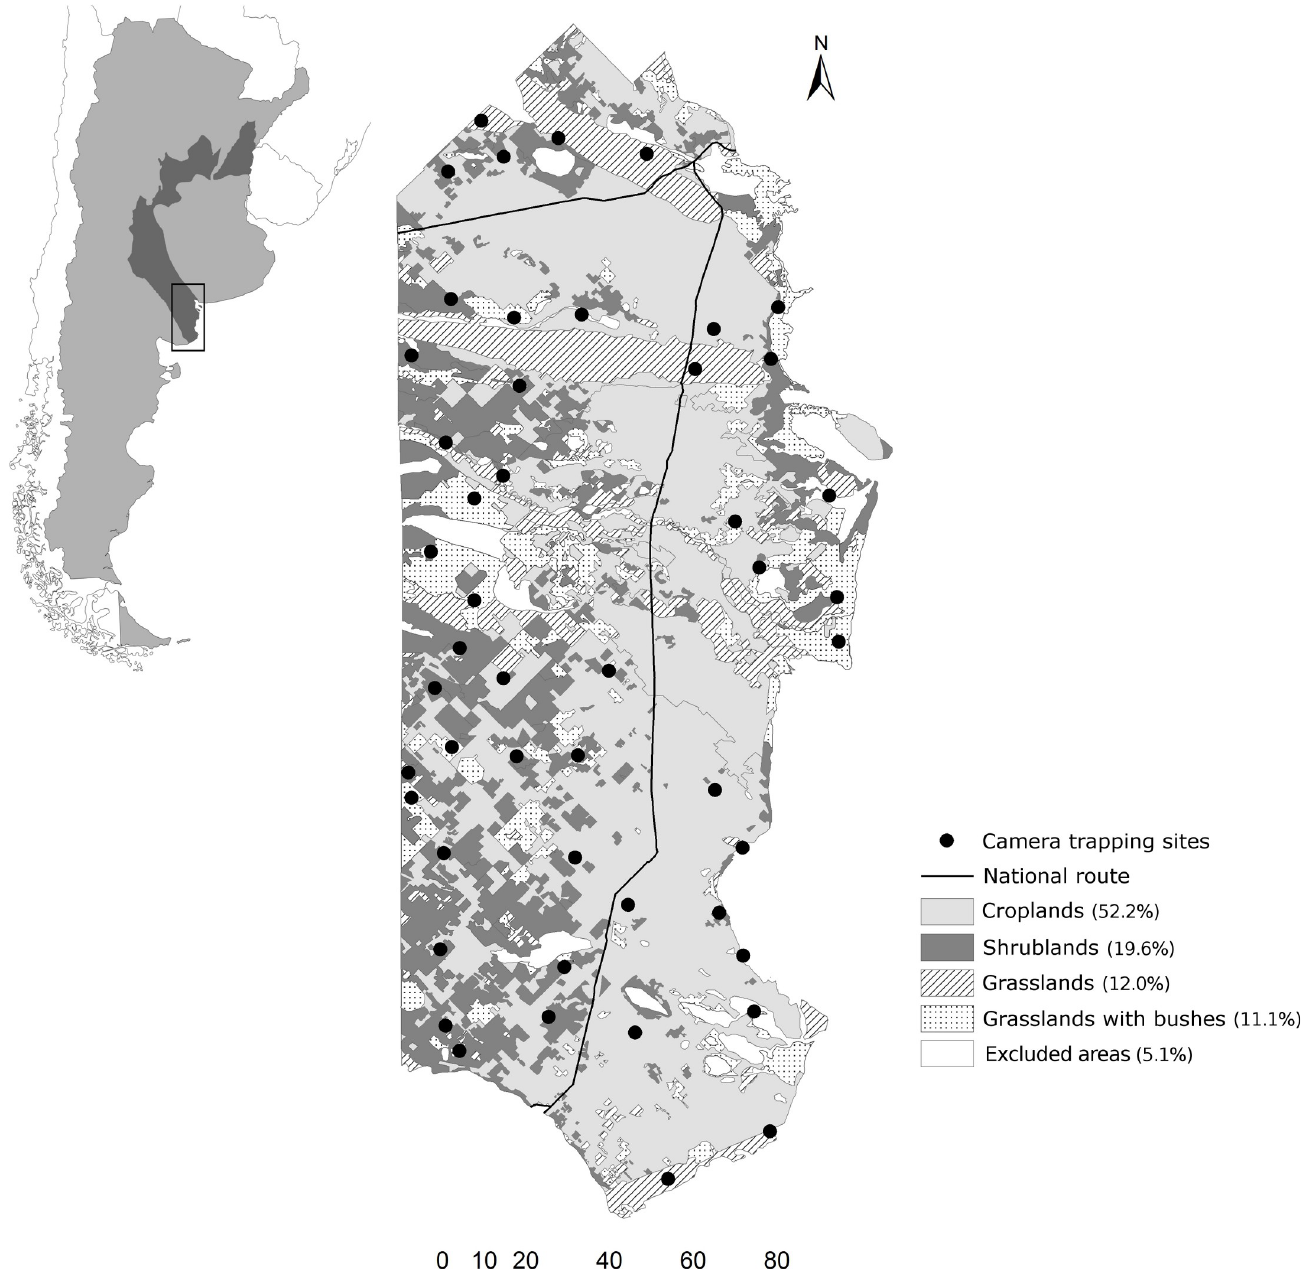
Fig 1. Study area. Map of the study area with the locations of camera trap sites. The dark area in the general map of Argentina represents the Espinal ecorregion. Modified from